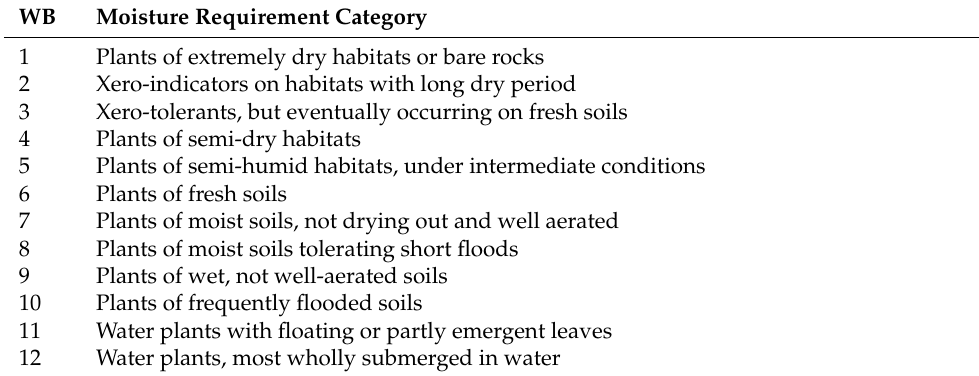
Table A1. The relative soil moisture requirement system, according to Borhidi [31].